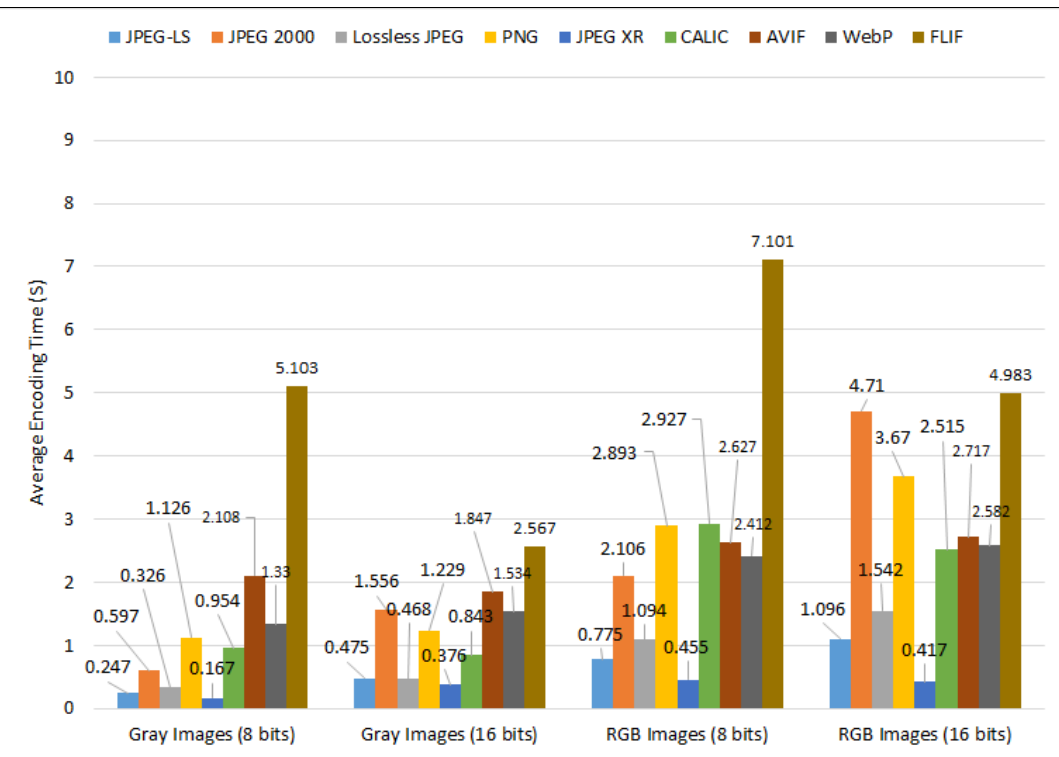
Figure 27. Comparison of average encoding